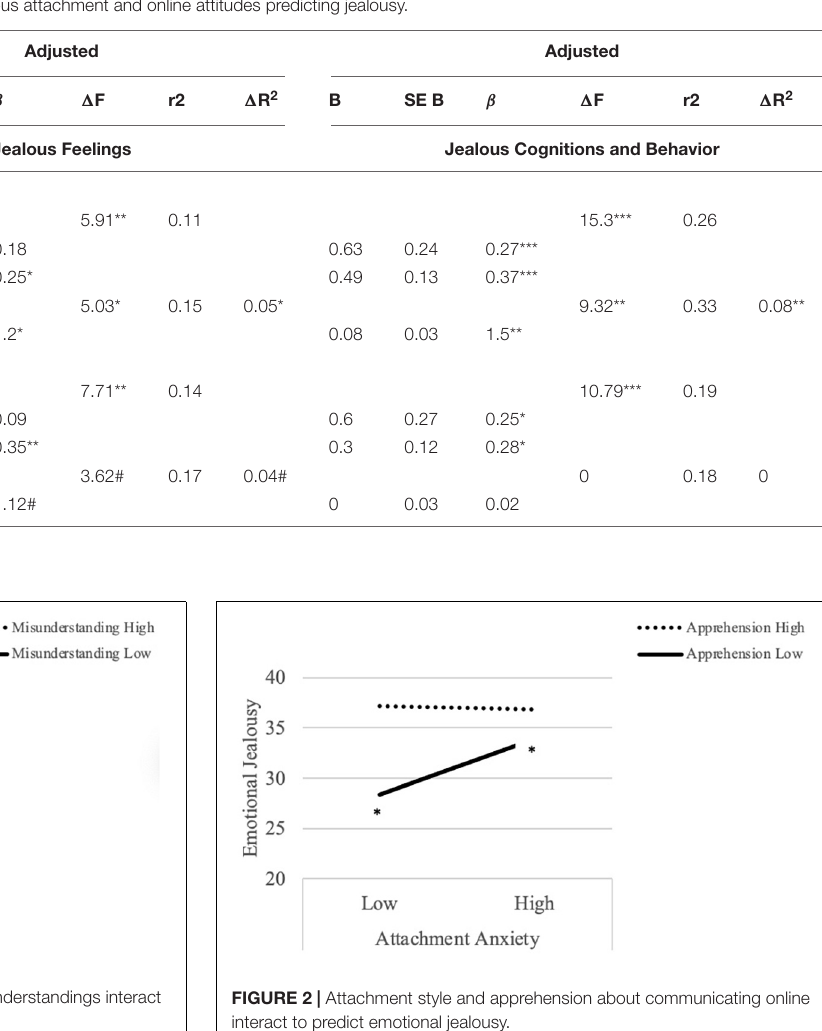
anxiety and apprehension.